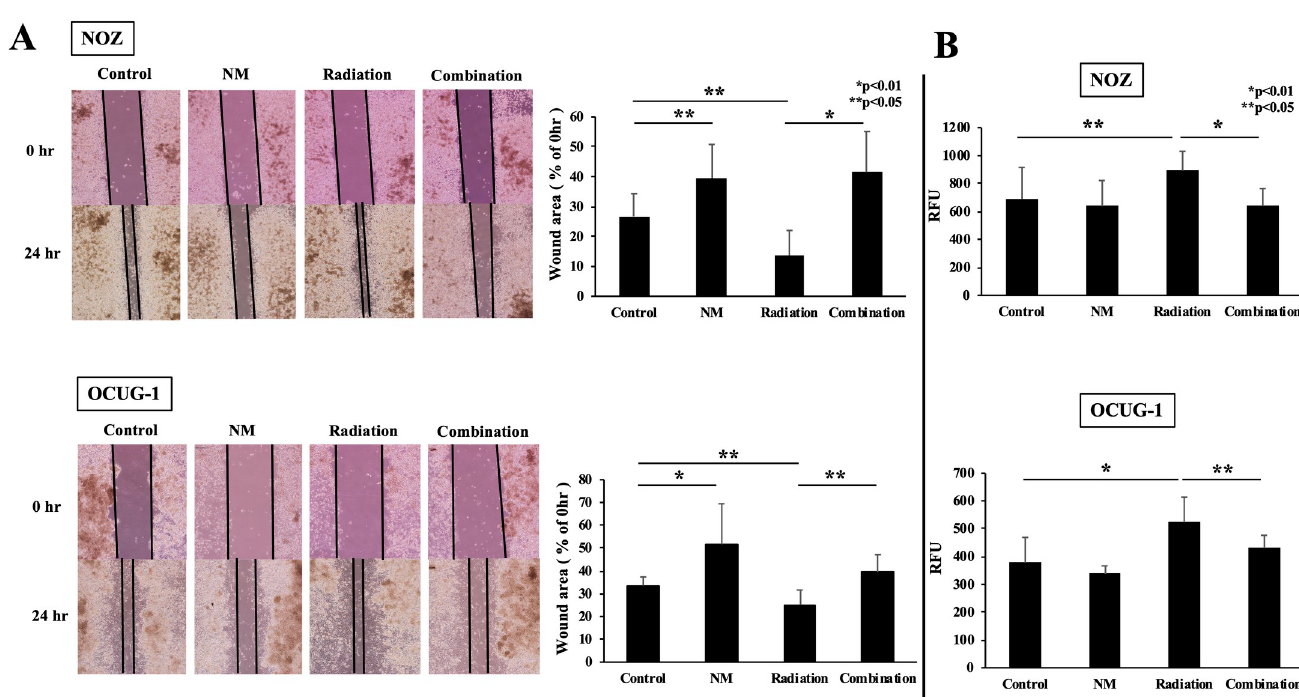
Fig 5. NM suppressed radiation-induced migration and invasion of GBC cells. (A) The wound area in the combination group was wider than in the radiation group for NOZ and OCUG-1 cells (NOZ: 41.5 ± 13.6% vs. 13.7 ± 8.3%, p < 0.01; OCUG-1: 39.4 ± 7.7% vs. 25.1 ± 6.5%, p < 0.05). (B) The invasion index in the combination group was lower than in the radiation group for NOZ and OCUG-1 cells (NOZ: 644.7 ± 118.6 vs. 891.1 ± 139.2, p < 0.01; OCUG-1: 430.6 ± 45.9 vs. 526.4 ± 87.5, p < 0.05). RFU: Relative fluorescence units.